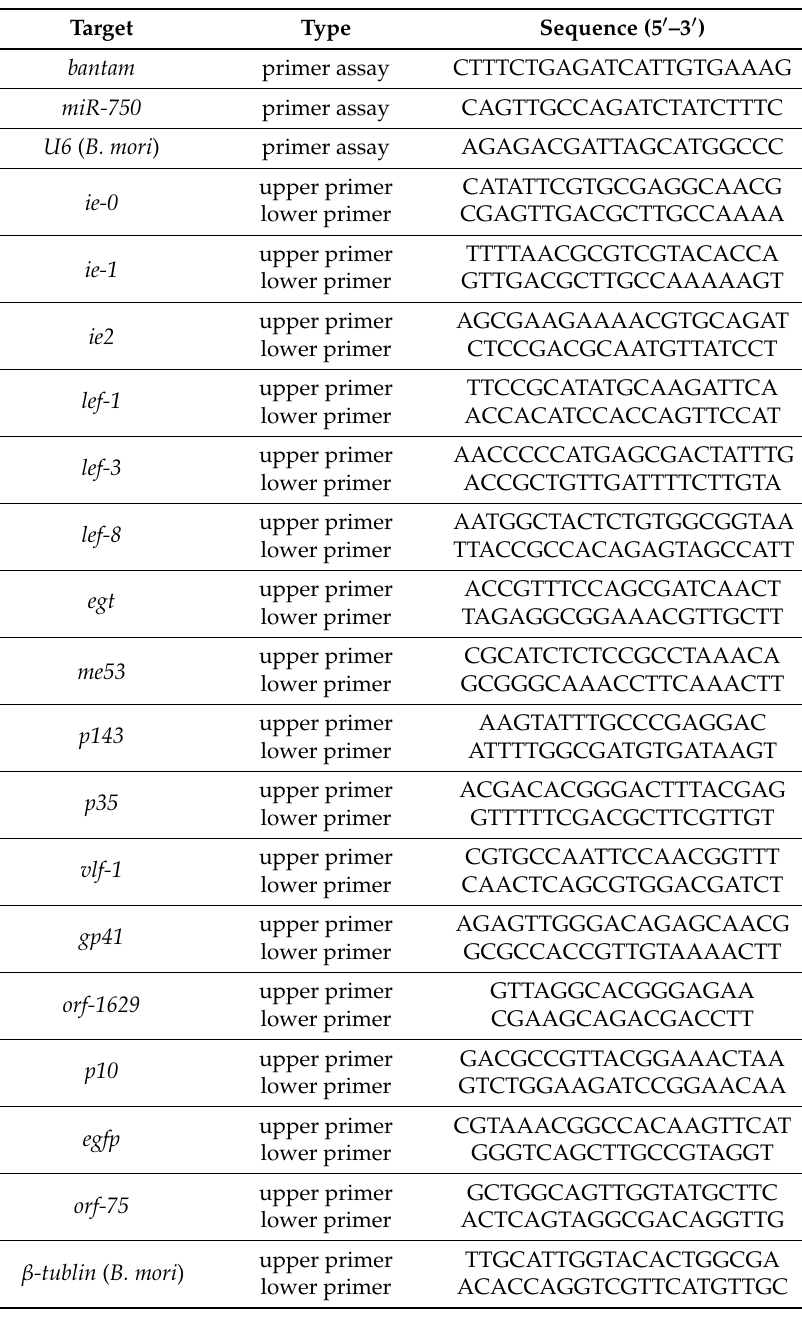
Table 1. Sequences of real-time PCR